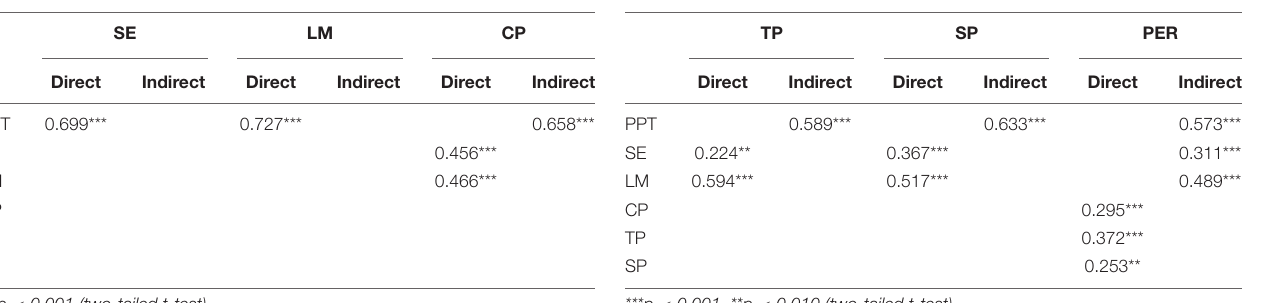
TABLE 5 | Structural model path coefficient (1). TABLE 6 | Structural model path coefficient (2).